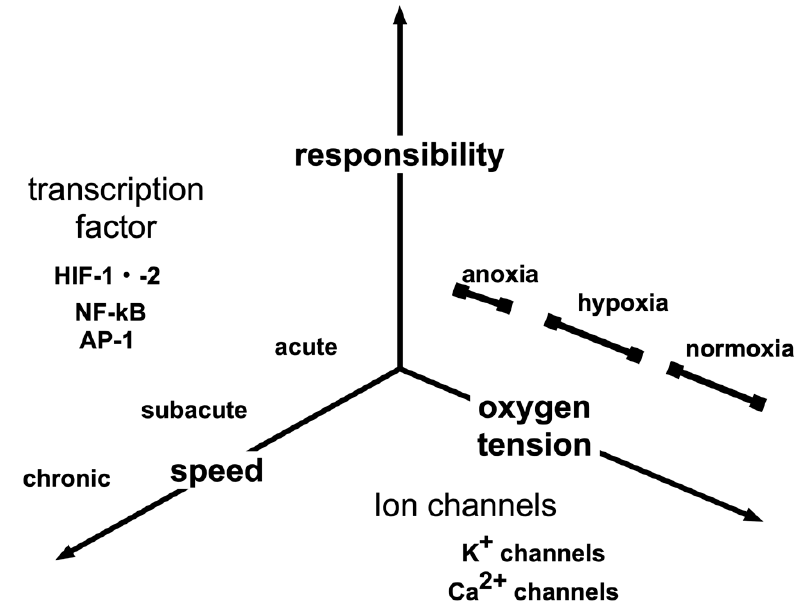
Figure 2. Various hypoxic responses. The hypoxic response of a living body may be classified in various ways according to the presence or absence of the gene response, rapidity and oxygen partial pressure that induces the response. In addition to HIF-1, transcription factors responsible for hypoxic responses include NF- κ B and AP-1, which are master transcription factors for inflammatory responses. Hypoxic responses may vary from those that are triggered quickly, within minutes, such as hypoxic pulmonary vasospasm responses, to those involving several hours, such as erythropoietin induction. In addition, high altitude adaptation may occur over a few weeks.